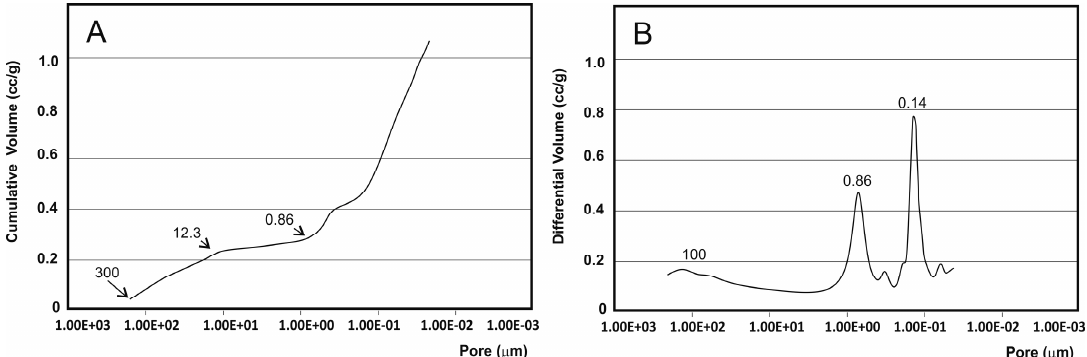
Figure 3. ( A ) Mercury intrusion curves of the ceramic measured by mercury porosimetry: cumulative intruded volume vs. pore diameter and ( B ) differential-intruded volume vs. pore diameter. The intrusion profiles show a small mercury penetration into pores between 300 and 12.3 µm (interparticle pores) and a significant mercury penetration into pores smaller than 0.86 µm (intraparticle pores).